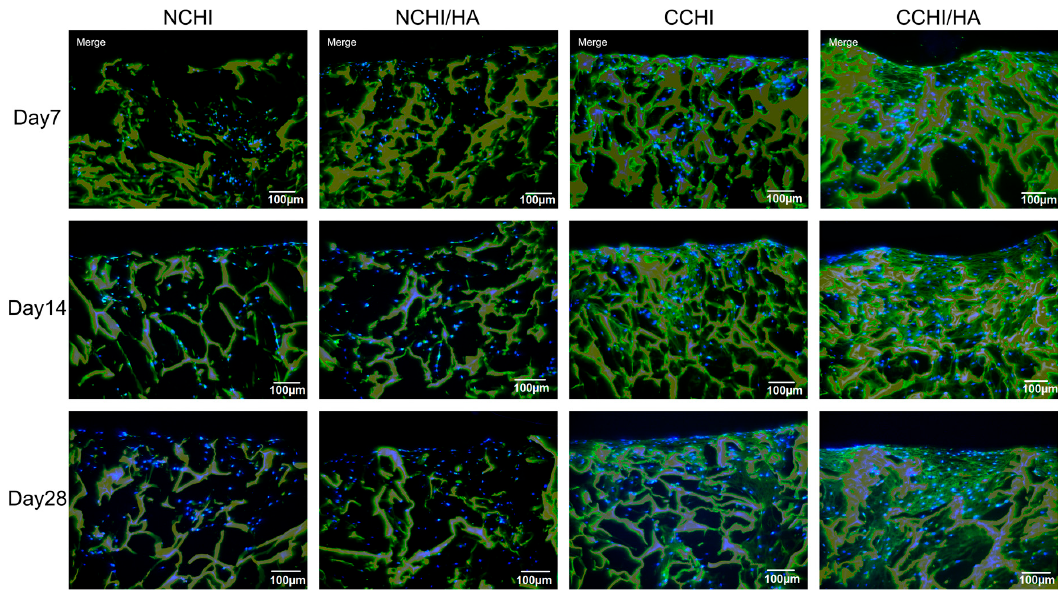
Figure 9. Immunofluorescence staining of collagen type II ( green ) at Day 7, 14, and 28 both in chitosan and chitosan with hyaluronic acid scaffolds with hADSCs cultured in normal (NCHI and NCHI/HA) or chondrogenic medium (CCHI and CCHI/HA). The chitosan and chitosan with hyaluronic acid scaffolds fluoresced yellow , whereas living cell nuclei fluoresced blue. Magnification set at